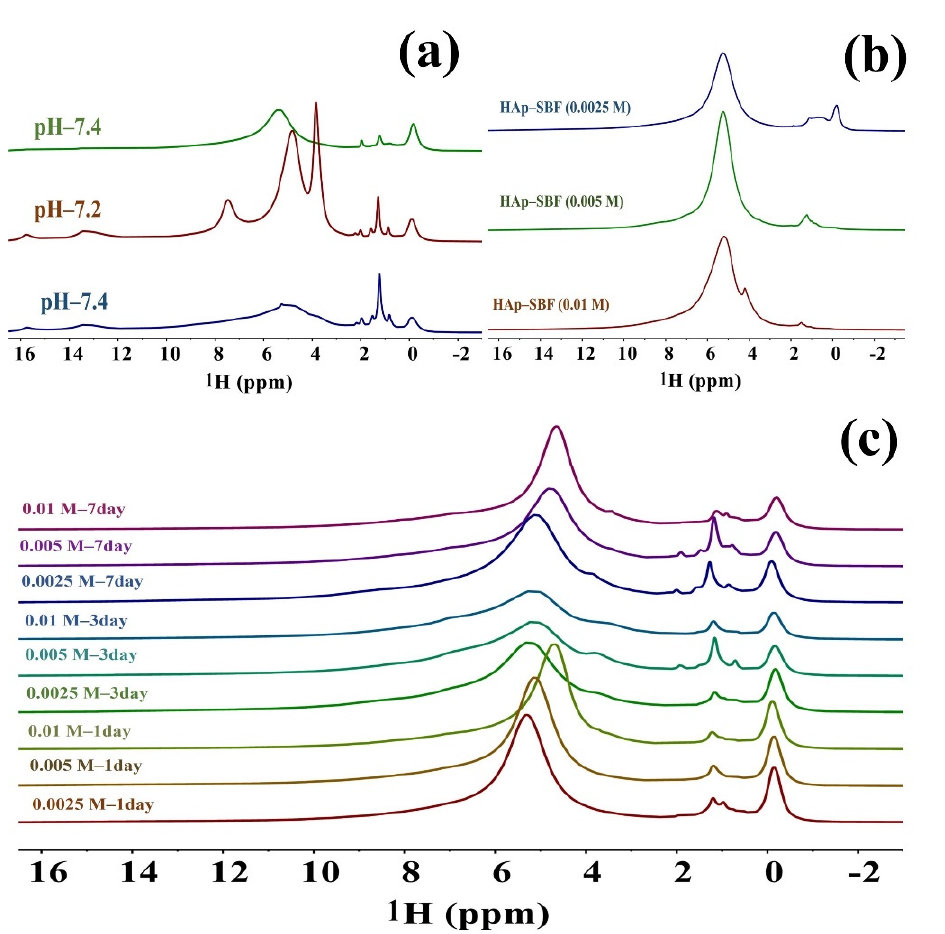
Figure 3. ( a ) 1 H 35 kHz MAS NMR spectra of HAp synthesized in different pH values; ( b ) 1 H 35 kHz MAS NMR spectra of F-HAp synthesized in BSF at different concentrations; ( c ) 1 H 35 kHz MAS NMR spectra of HAp soaked in NaF solutions with different concentrations and different times.